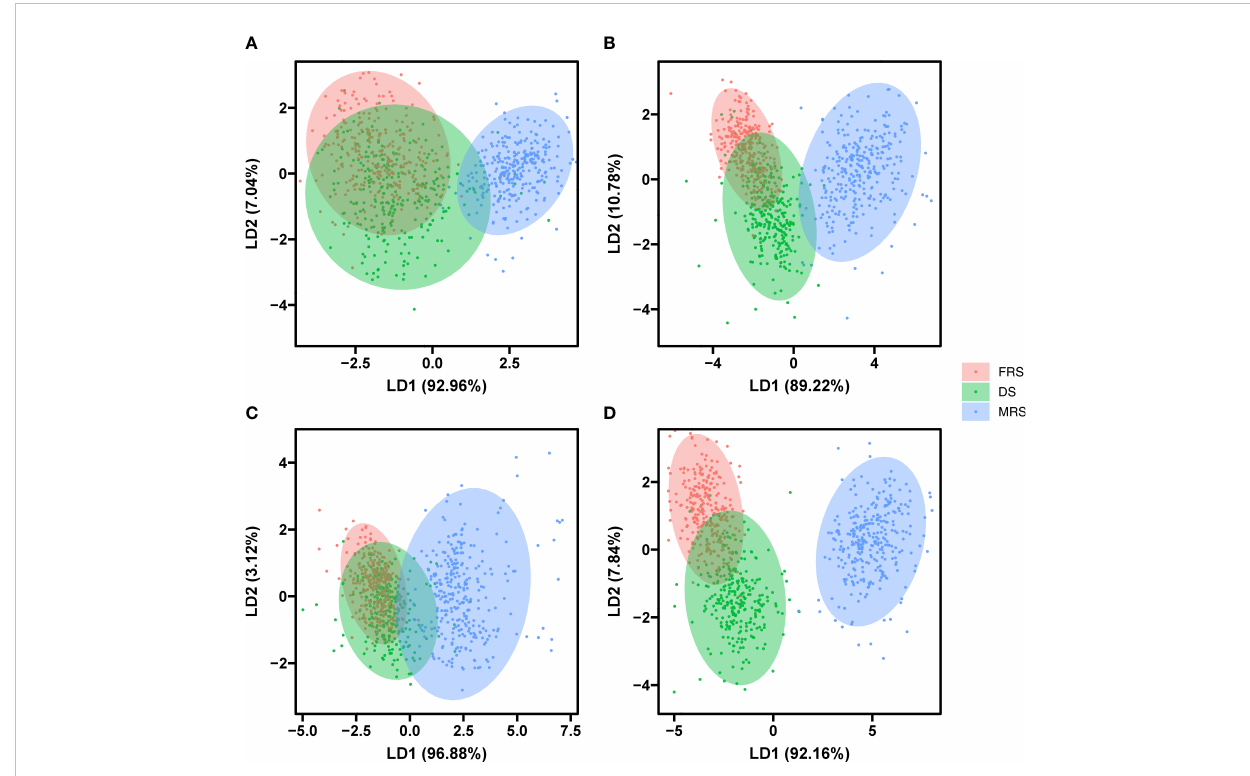
FIGURE 7 Two-dimensional biplot of LDA scores distinguishing seeds of three stage Siberian wildrye seeds based on morphological data (A) , multispectral data (B) , auto fl uorescence data (C) , and multi-source fusion data (D)